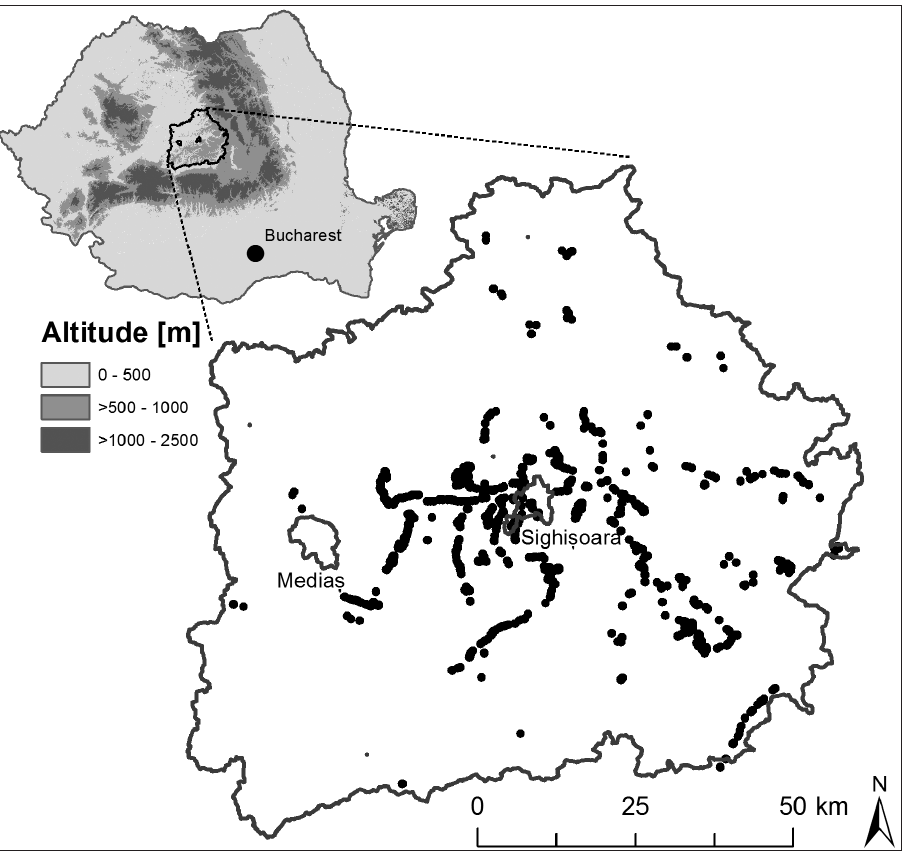
Figure 1. Location of our study area in Romania. Inside the enlarged map of our study area the cities Mediaș and Sighișoara are outlined and black points represent the presence points of all eight study